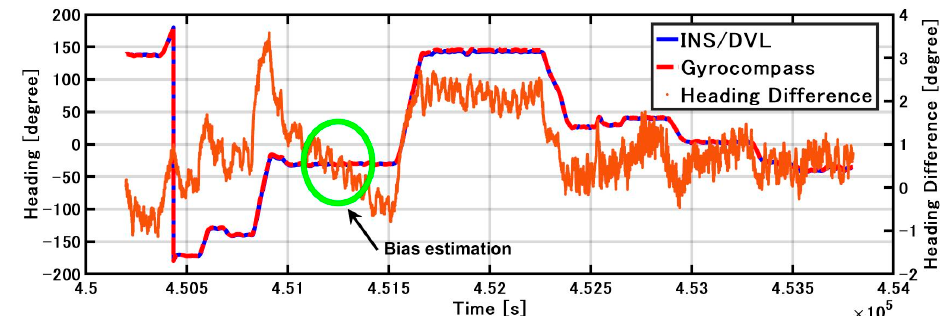
Figure 16. Horizontal error.